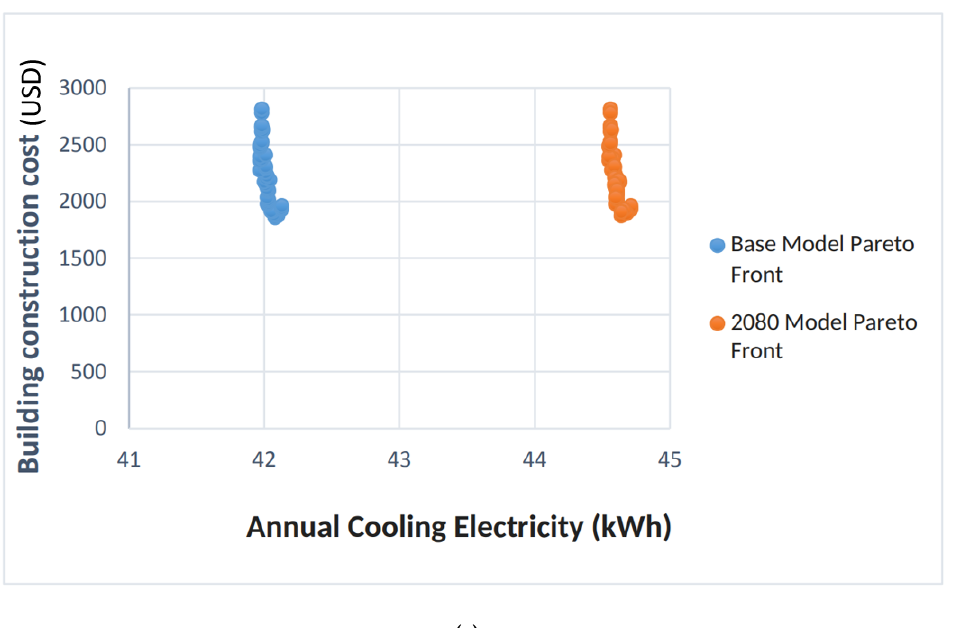
Figure 12. ( a )Two-dimensional passive optimization for heating load, and building construction cost. ( b ) Two-dimensional passive optimization for heating load, and cooling load. ( c ) Two-dimensional passive optimization for cooling load, and building construction cost.